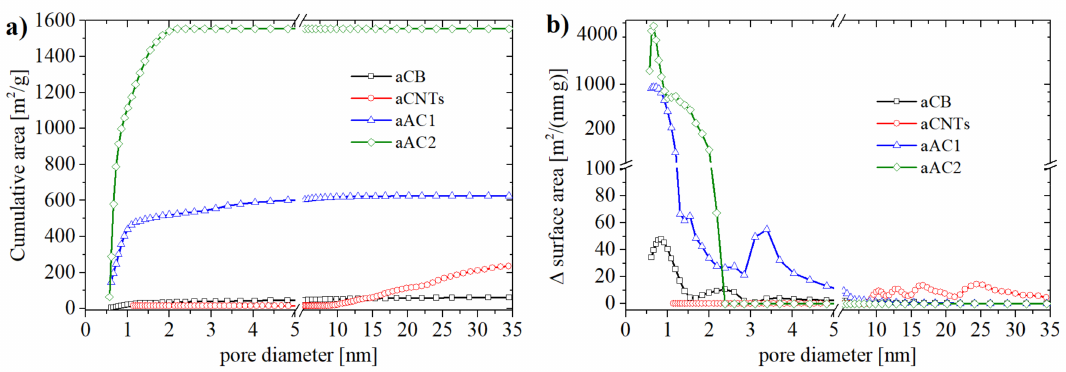
Figure 2. Quenched solid Density Functional Theory (QSDFT) analysis: ( a ) Cumulative pore areas and ( b ) pore size distribution (aCB, aAC1, aAC2: slit pores; aCNTs: cylindrical pores). SSA values (BET) of the carbon materials were between 60 m 2 g − 1 (aCB) and 1760 m 2 g − 1